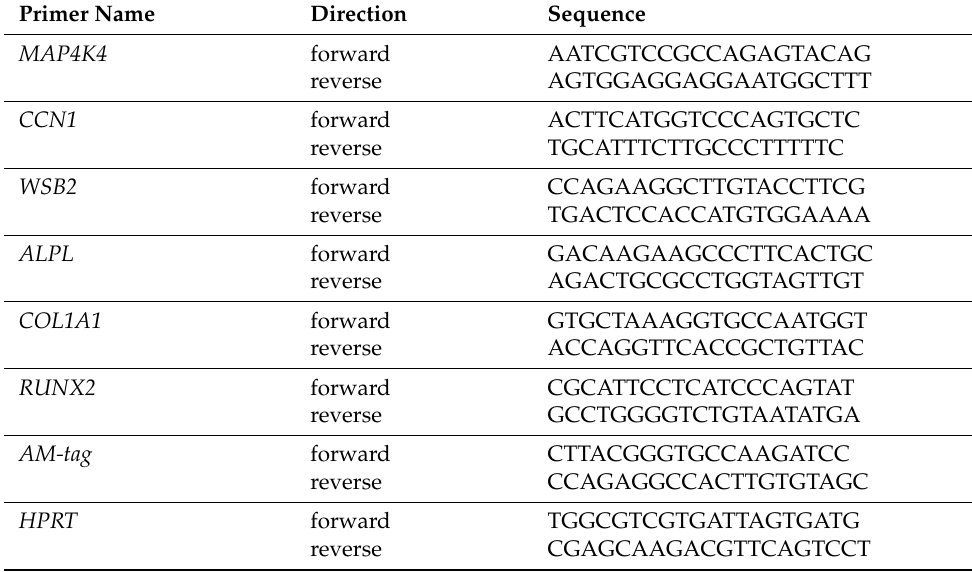
Table A1. PCR primer sequences for target genes.